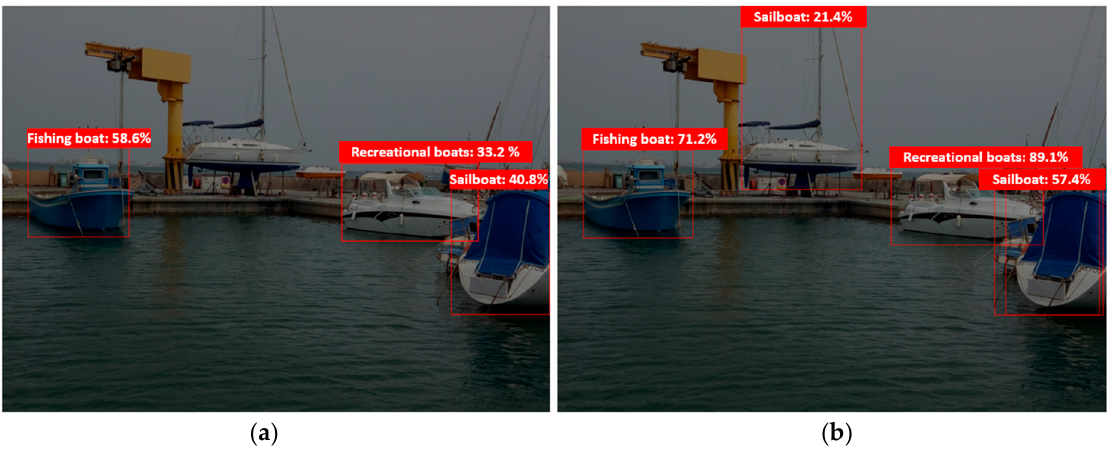
Figure 15. Edge ( a ) and cloud ( b ) trained model recognition tests.